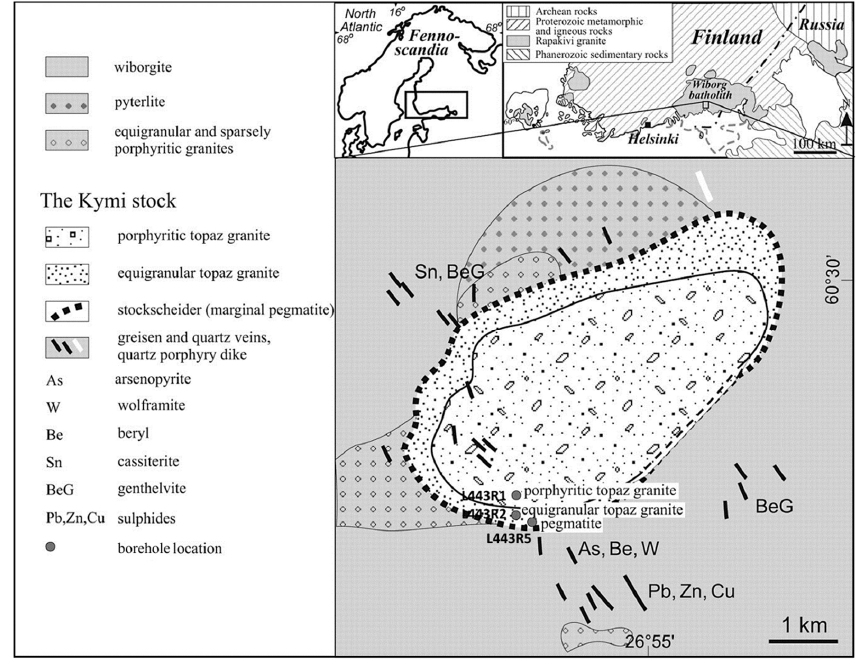
Figure 14. Geological map of the Kymi topaz granite stock in the Vyborg rapakivi batholith, south-eastern Finland. Modified from Lukkari et al. [64].